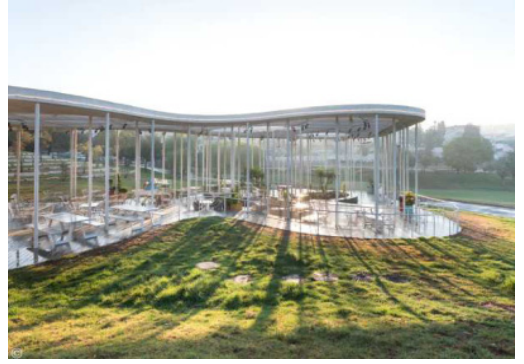
Figure 4. Sacher Park Cafe (2018, Jerusalem, Israel) [57].